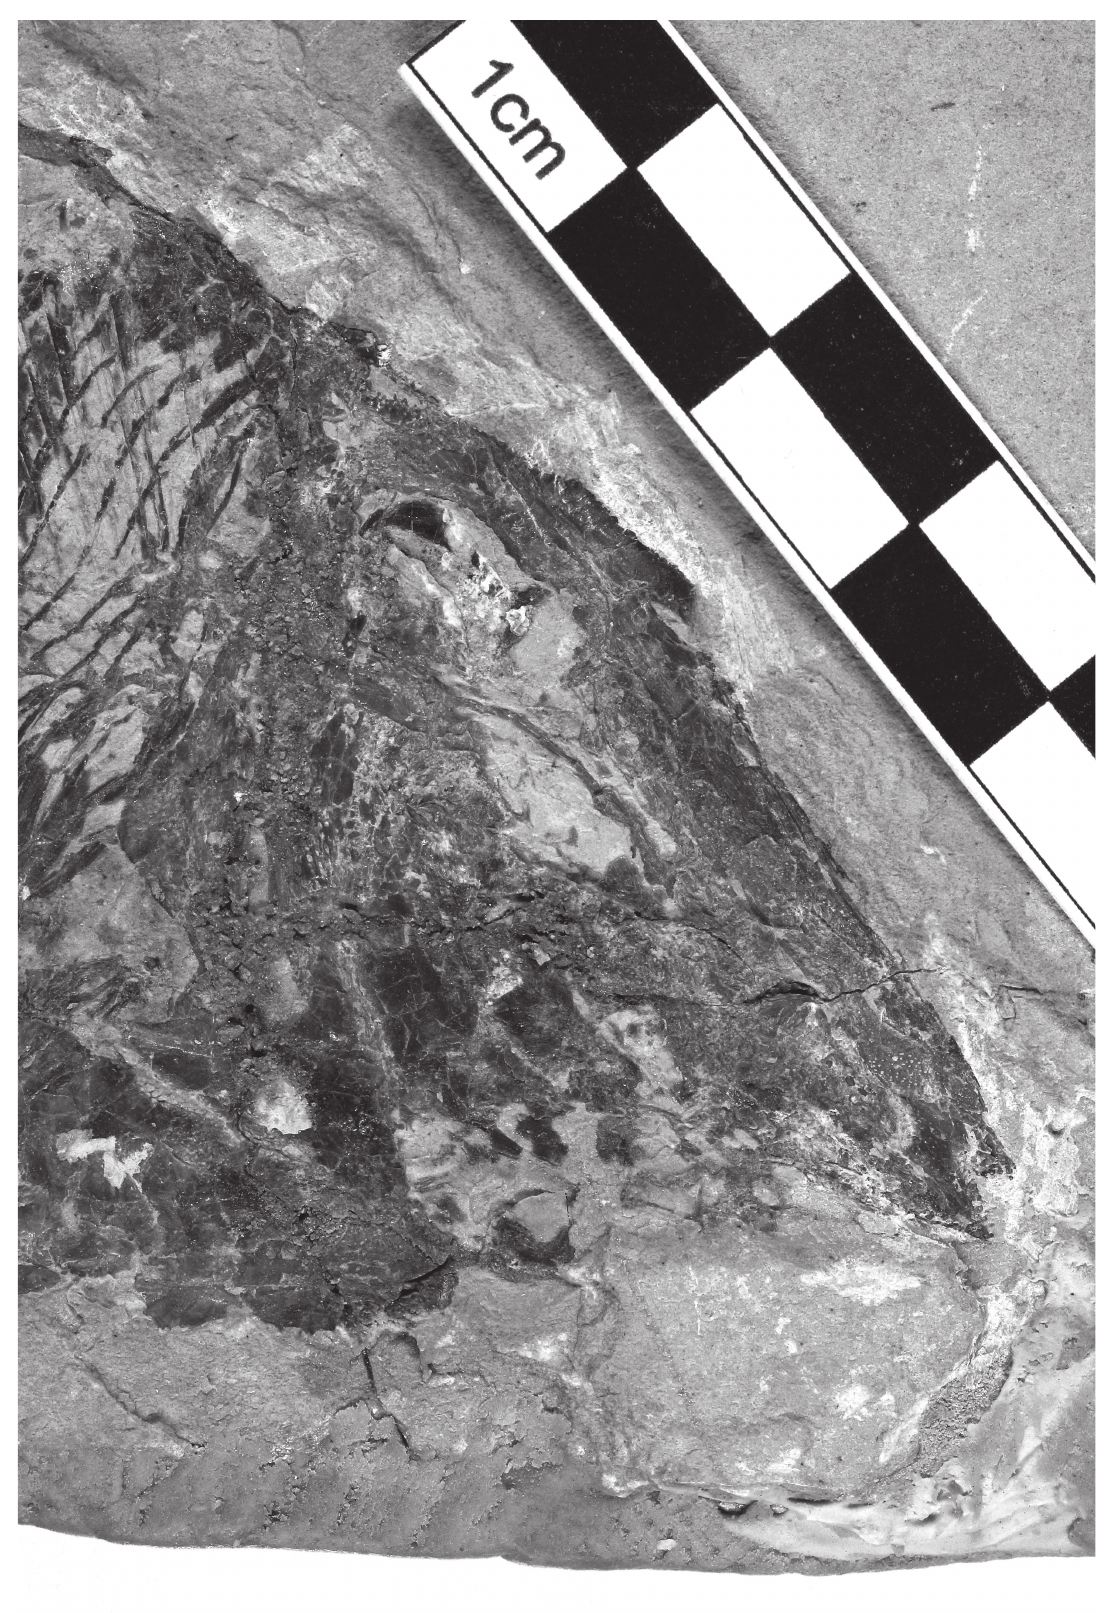
Fig. 9. Acrorhinichthys poyatoi gen. et sp. nov. Head and anterior region of paratype CLC